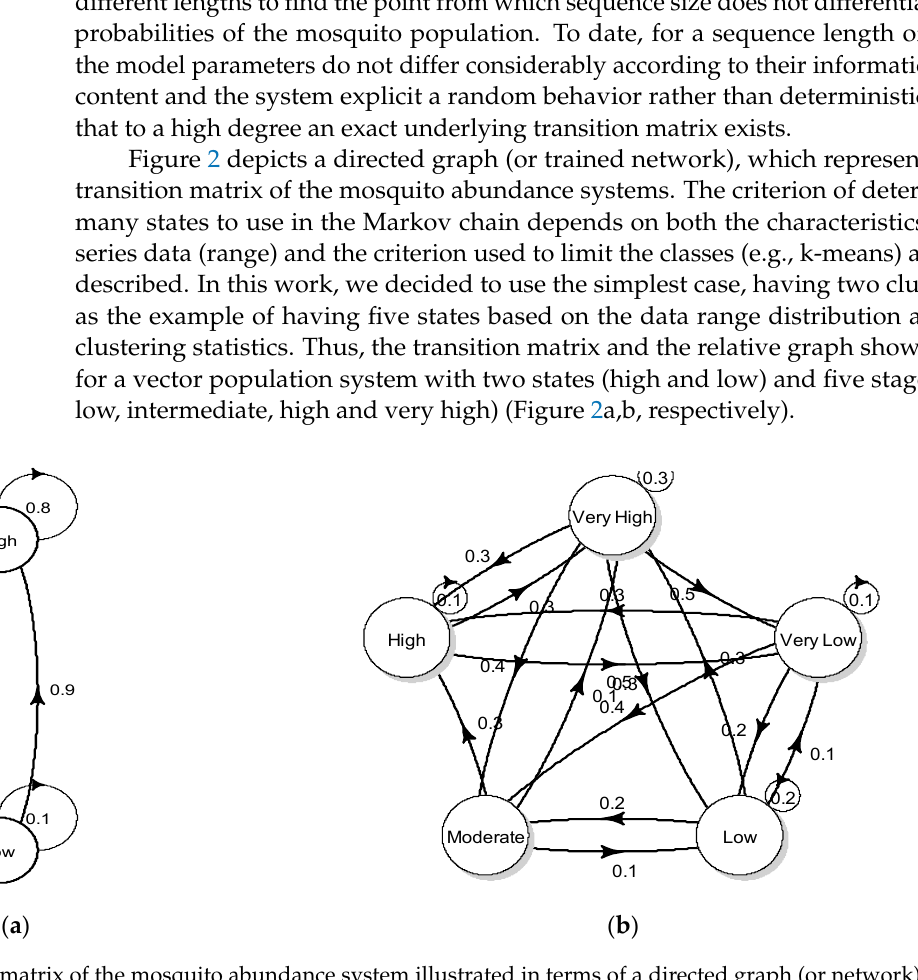
Figure 2. Transition matrix of the mosquito abundance system illustrated in terms of a directed graph (or network). ( a ) The transition matrix has been constructed for two states (high and low) and ( b ) for five stages (very low, low, intermediate, high and very high). Values indicate the probabilities of transitions.